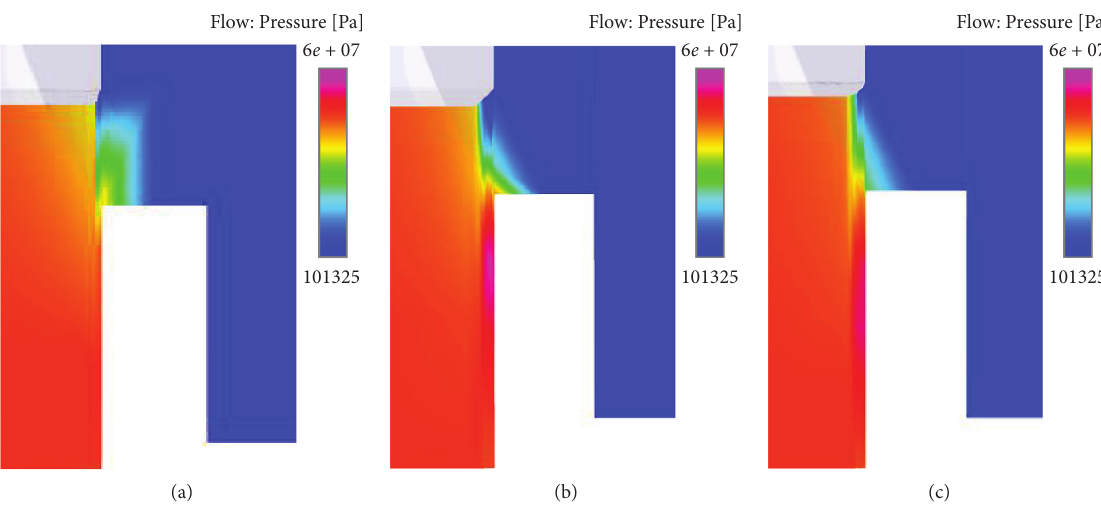
Figure 24: Pressure distribution near main valve seat hole under stable condition. (a) 30-degree chamfer. (b) 45-degree chamfer. (c) Arc chamfer.